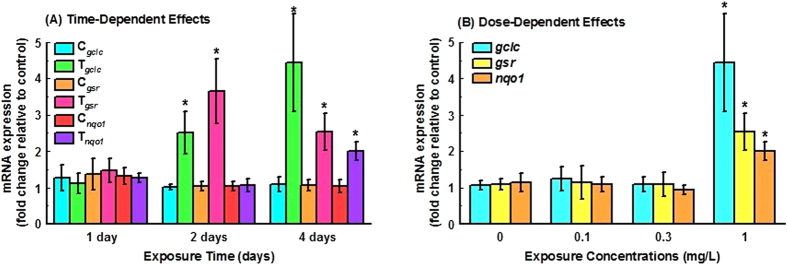
Dose- (A) and time-dependent (B) effects on the expression of selected hepatotoxicity biomarker genes (gclc, gsr and nqo1) in response to TDCIPP.(C): control group; T: treatment group. Values represent mean ± SEM (n = 9). Asterisks indicate significant differences from matched control samples (P < 0.05).